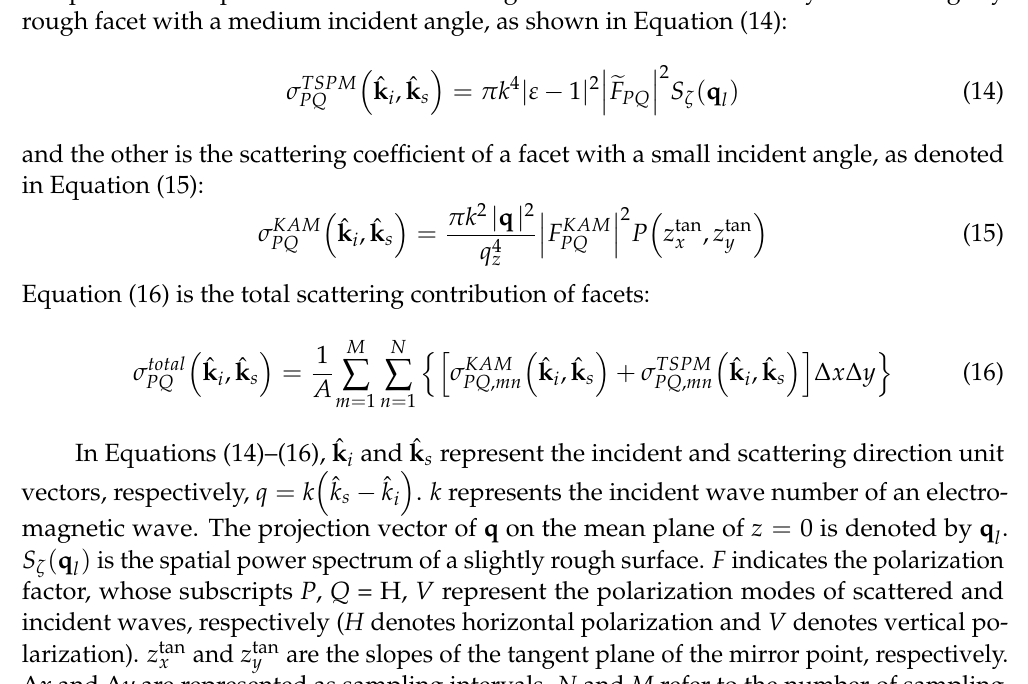
Figure 4. The simulated sea surface-Kelvin wake composite scene. ( a ) The ship speed is 6 m/s, and the wind speed is 3 m/s; ( b ) The ship speed is 6 m/s, and the wind speed is 5 m/s.